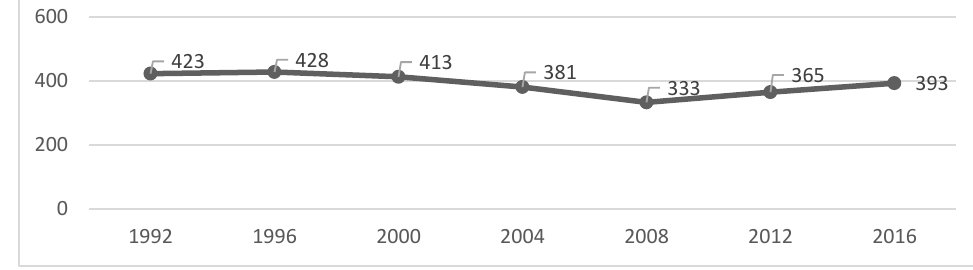
Figure 1. Gold medals evolution all over the editions.